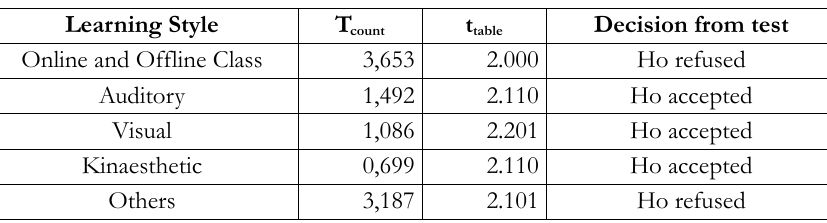
Table 12. Comparison Test on the Mathematic connection on Online and Offline